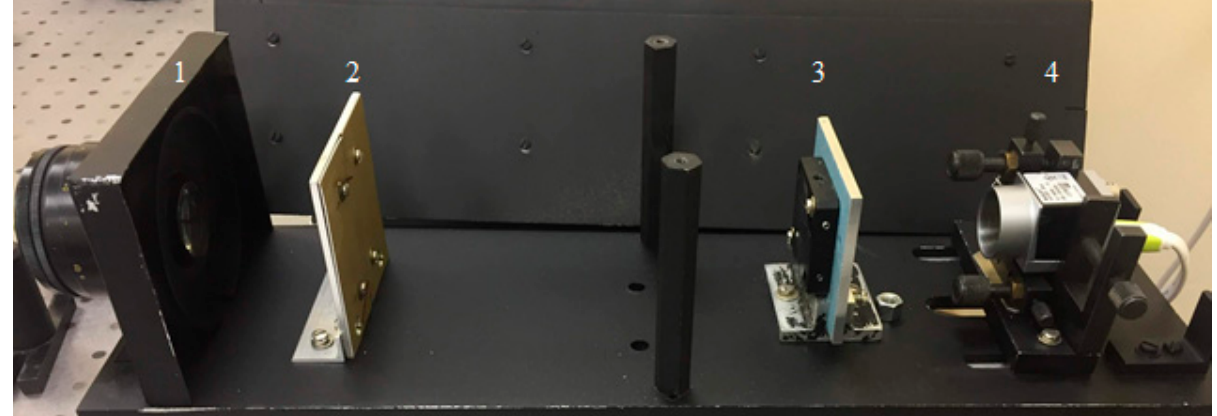
Figure 11. An experimental optical setup.